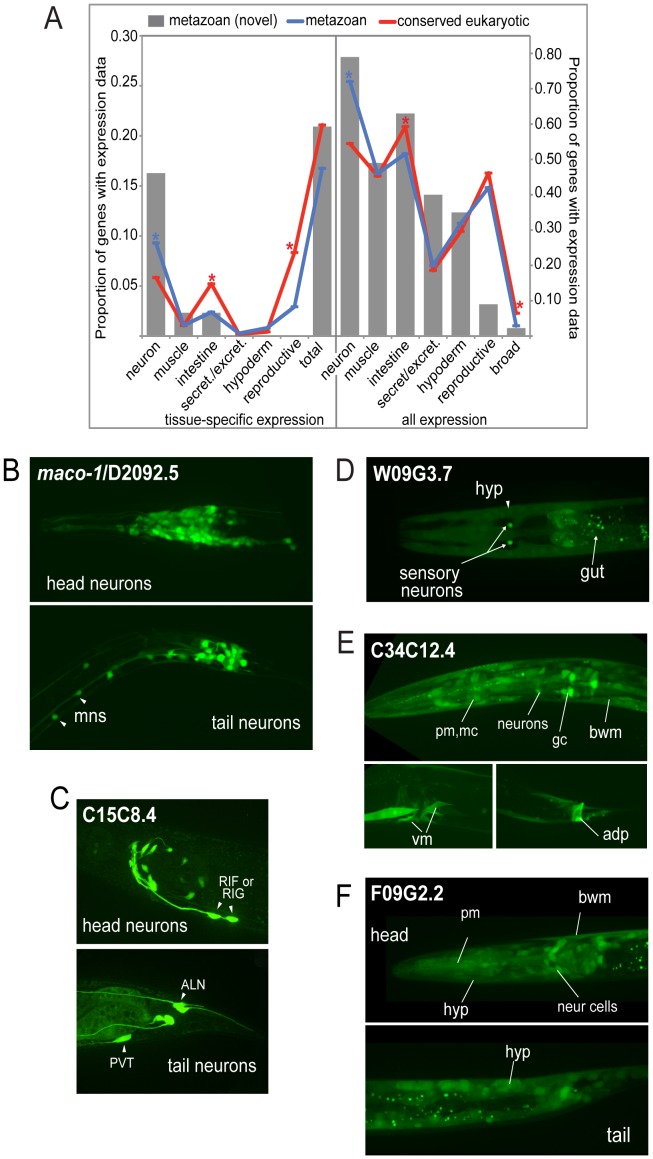
Expression patterns of metazoan-specific genes in C. elegans.A. Global analysis of expression patterns of metazoan and widely conserved eukaryotic genes. Expression patterns were categorized as neuronal, muscle, intestinal, secretory/excretory, hypodermal or reproductive, and quantified using GExplore [14]. The left panel shows only tissue-specific expression and the right panel shows all expression. Grey bars show novel metazoan-specific expression patterns determined in this study, blue lines show expression patterns of metazoan-specific genes (previously characterized plus the 43 novel expression patterns collected in this study), and red lines show expression patterns of widely conserved eukaryotic genes. Asterisks indicate statistically-significant differences between metazoan (blue) and conserved eukaryotic (red) genes (p<0.05, Fischer's exact test). B–F. Sampling of novel expression patterns of genes investigated in this study. (B) Pan-neuronal expression of D2092.5 (maco-1), ortholog of macoilin, a transmembrane and coiled-coil domain-containing protein. Our data are consistent with studies published during the course of our investigation that showed neuronal-specific expression pattern for this protein and an involvement in neuronal functions in C. elegans
[42], [43], motoneurons (mns) in the ventral nerve cord are indicated. (C) Neuronal-specific expression of C15C8.4, homolog of LRPAP1 a low-density lipoprotein receptor-related protein tentatively associated with degenerative dementia [77]. Cells expressing C15C8.4 includes RIF or RIG, RIS, 8–10 additional head neurons, and PVT/ALN (a pair of tail neurons), (intestine staining here is unspecific). (D) W09G3.7, homolog of WBSCR16 a predicted RCC1-like nucleotide exchange factor is expressed in a few tissues, hypoderm, intestine and a pair of sensory neurons. (E) C34C12.4, homolog of human C4orf34, is expressed in a subset of neurons in the head, body wall muscle (bwm), intestinal cells, gland cells (gc), vulva muscle and anal depressor (adp). (F) Nearly ubiquitous expression of F09G2.2, a cyclin domain-containing protein homolog to human C2orf34; neuronal and non-neuronal cells in head and tail, pharyngeal muscle (pm), body wall muscle, hypoderm, intestinal cells. Except for D2092.5, the genes are functionally uncharacterized.